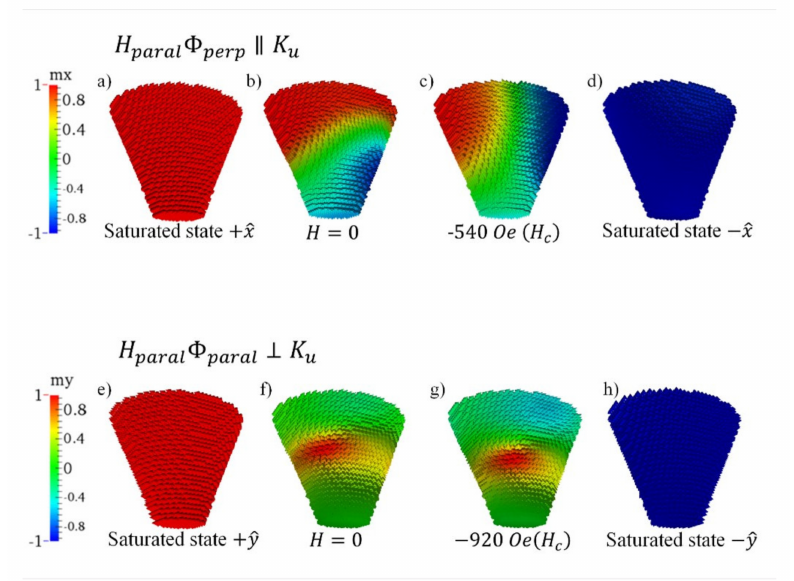
Figure 7. Snapshots of the stable magnetization state corresponding to the R-mask sample. K u is the uniaxial magnetic anisotropy constant in the H paral Φ perp direction. Top row is for magnetic field applied along the H paral Φ perp direction with different values: ( a ) H = 25,000 Oe (i.e., saturated state in the positive direction), ( b ) H = 0, ( c ) H = − 540 Oe, ( d ) H = − 25,000 Oe (i.e., saturated state in the negative direction). Bottom row is for magnetic field applied along the H paral Φ paral direction with different values: ( e ) H = 25,000 Oe (i.e., saturated state in the positive direction), ( f ) H = 0, ( g ) H = − 920 Oe, ( h ) H = − 25,000 Oe (i.e., saturated state in the negative